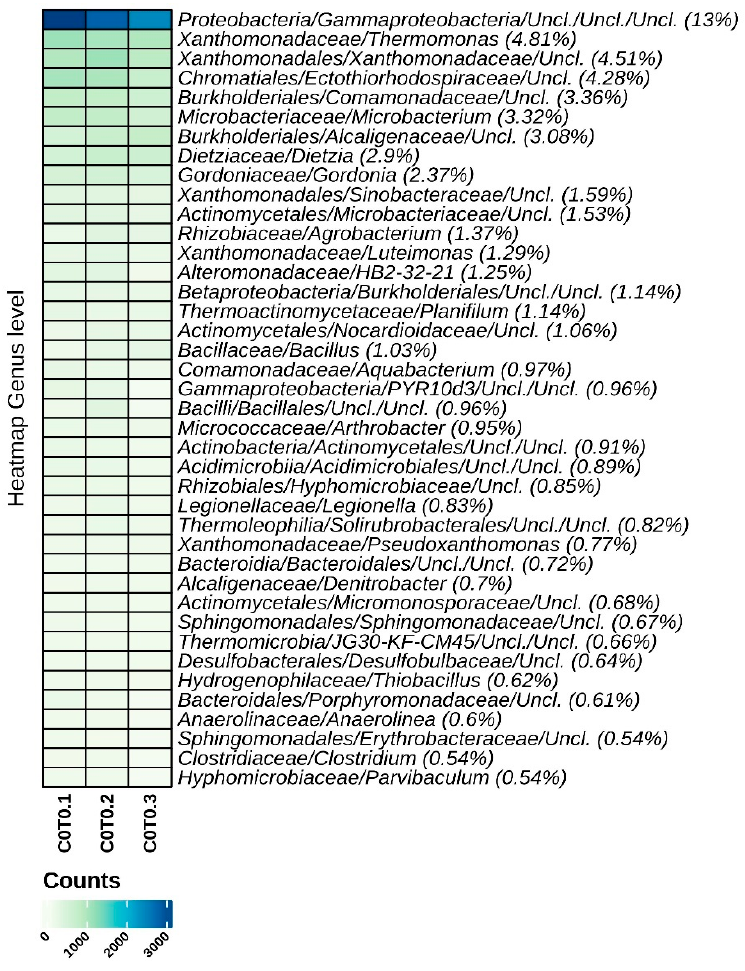
Figure 1. Taxonomic Heatmap showing the 40 most abundant ASVs in terms of absolute counts, aggregated at the Genus level for three biological replicates of the contaminated soil. On each row the nearest identified taxonomic levels, per ASV, are reported. The following percentage indicates their abundance relative to the total. Hierarchical clustering was performed on columns by Pearson correlation, based on Euclidean distance .